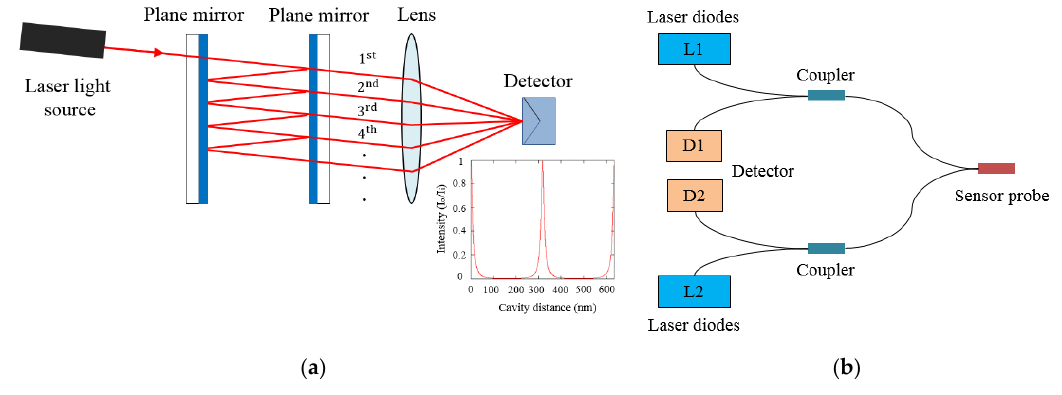
Figure 1. Optical arrangement of Fabry–Pérot interferometer: ( a ) Conventional structure, and ( b ) quadrature phase-shifted fiber-optic structure.